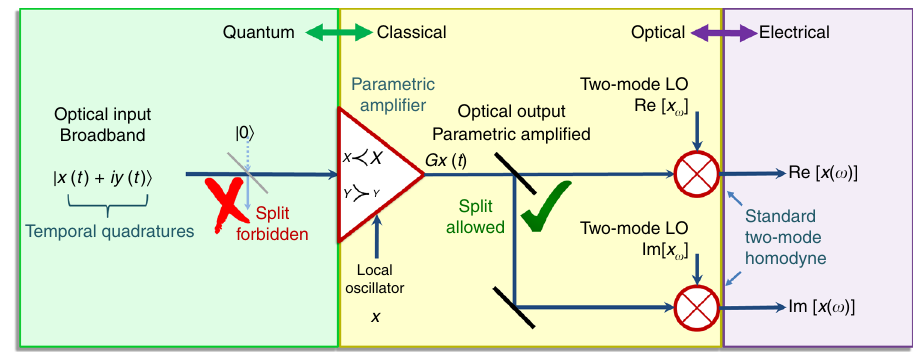
Fig. 4 A Complete broadband homodyne scheme. Parametric homodyne allows to fully measure the two-mode quadrature amplitude; once the quadrature of interest x ( ω ) is suf fi ciently ampli fi ed above the vacuum level by the parametric ampli fi er, this quadrature becomes insensitive to additional vacuum noise, which allows splitting of the light into two standard homodyne channels in order to measure simultaneously both Re x ( ω ) and Im x (